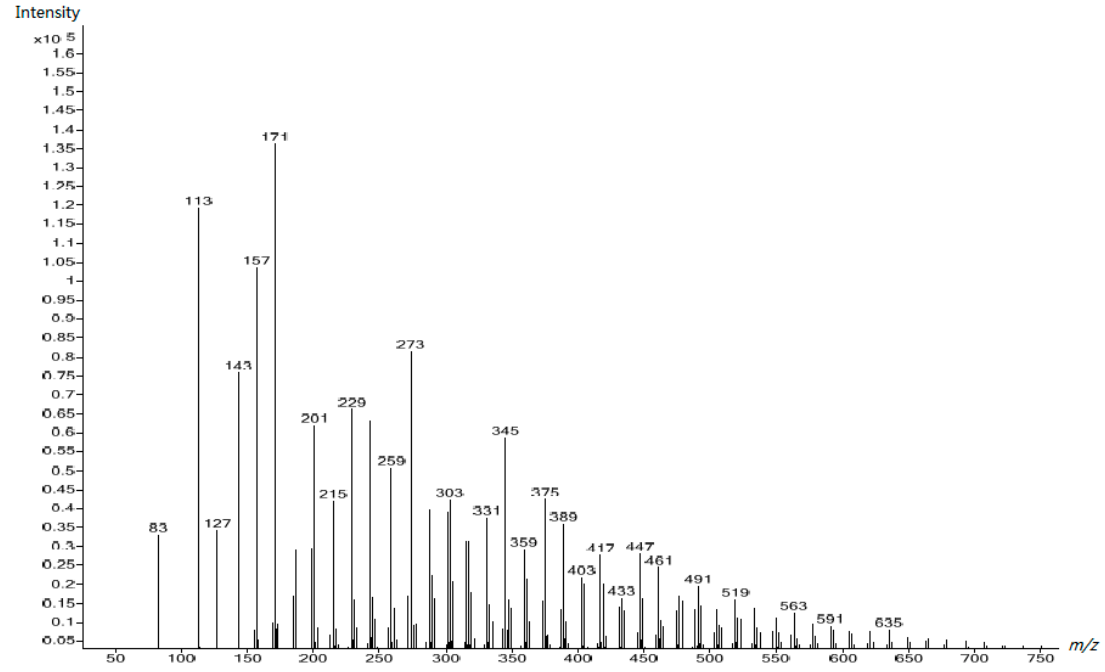
Figure 12. The ESI–MS spectrum of UF-5.